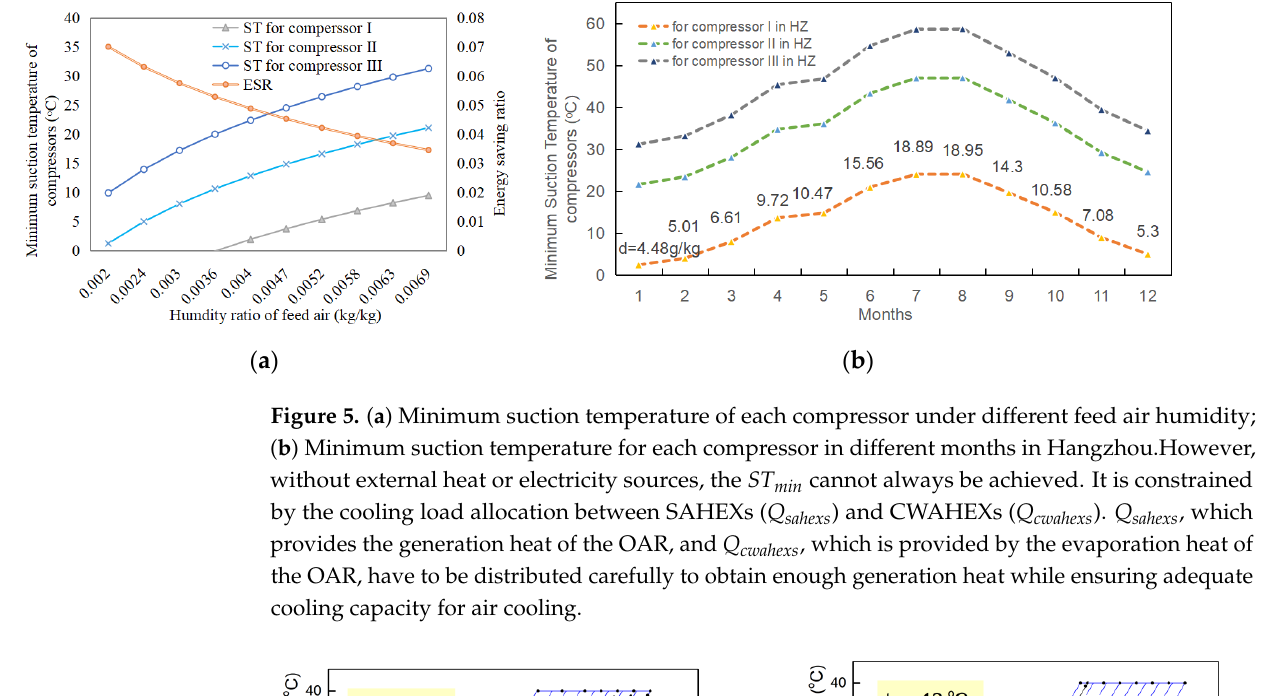
◦ C, FR s-a =2.3; ( c ) T eva = 12